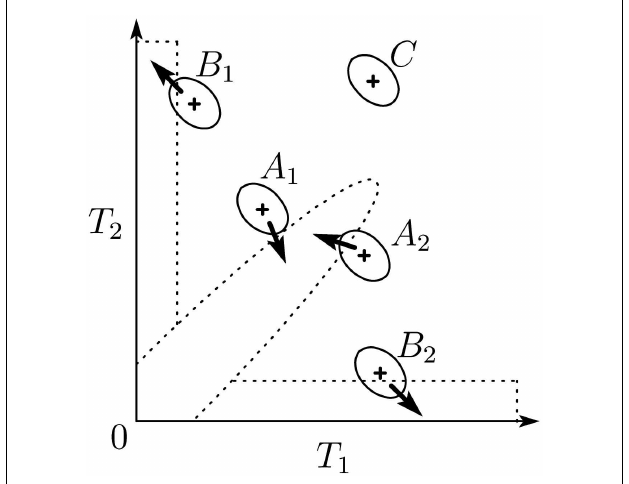
FIGURE 3 | Schematic figure of the model mechanism. Dashed lines indicate the shape of the prior distribution. Each solid-lined ellipse represents the likelihood function given an observed interval pair marked as a plus sign on the center of the ellipse. Each arrow describes the direction of the perceptual shift.